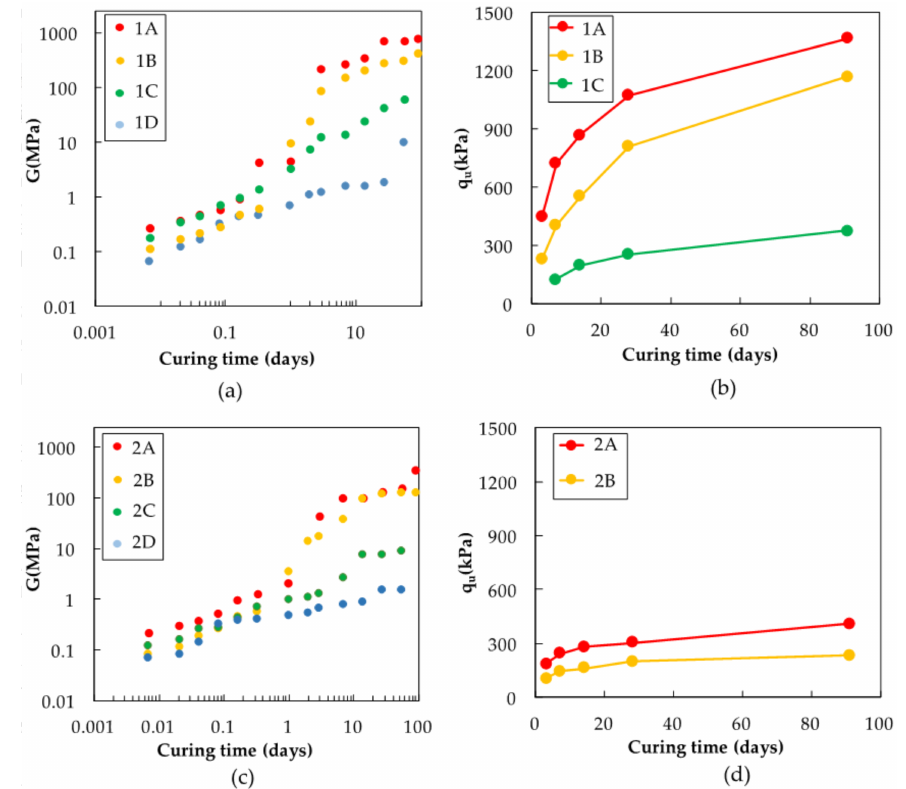
Figure 2. Variation of mechanical properties of mixtures: ( a , c ) show the shear modulus (G) of the mixtures, and ( b , d ) show the unconfined compressive strength (q u ) of the